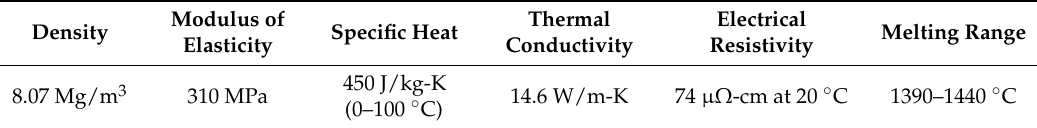
Table 2. Mechanical properties of AISI 316L SUS wire.